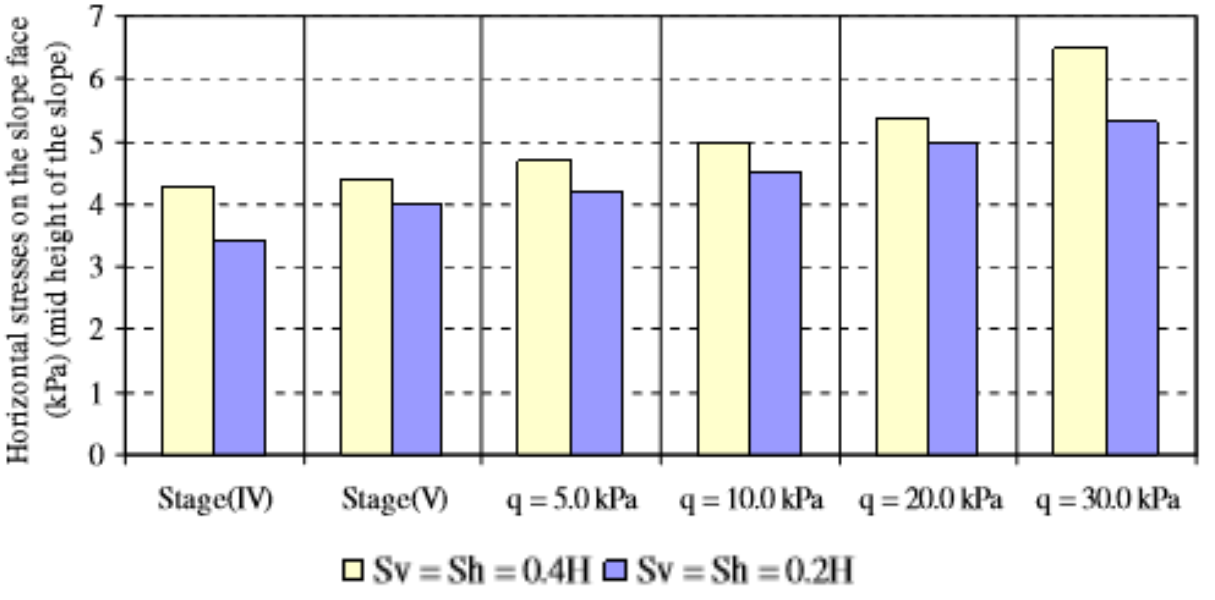
Figure 25. Influence of nail inclination on the slope face horizontal stresses at mid height of slope.